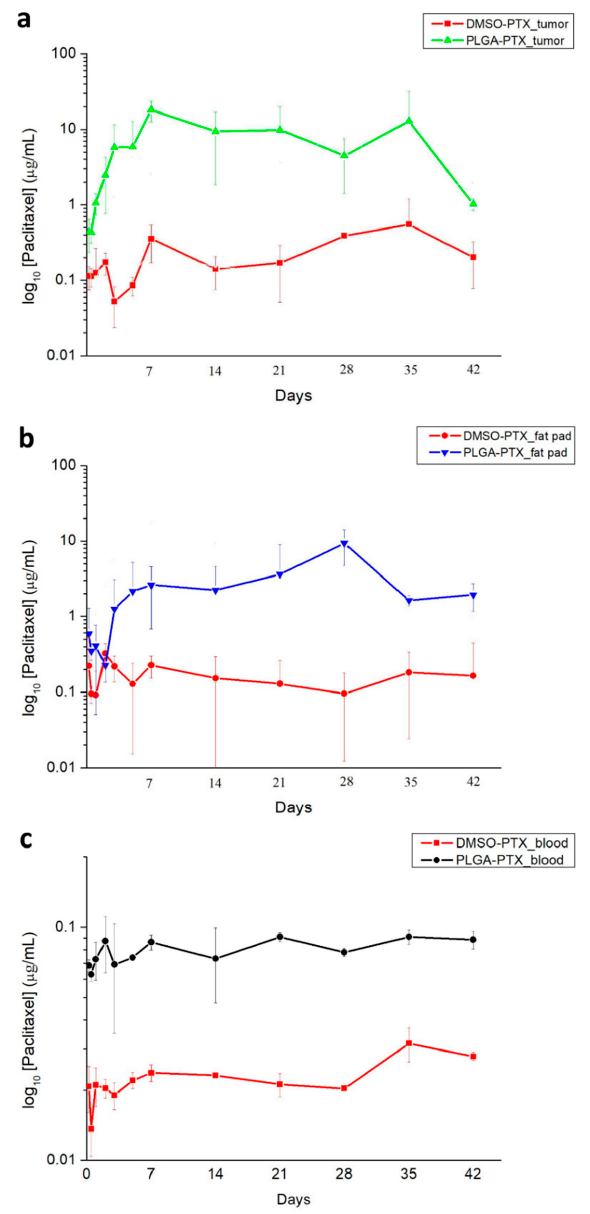
Figure 10. PTX concentrations in the tumor, fat pad, and peripheral blood. PTX was not detectable in DMSO-Ctrl and PLGA-Ctrl groups. PTX concentrations in the tumor ( a ) and fat pad ( b ) were much higher in the PLGA-PTX group than in the DMSO-PTX group from day 3 to day 42. ( c ) Plasma PTX concentrations. The PTX concentration was consistently higher in the PLGA-PTX group than in the DMSO-PTX group throughout the 42-day